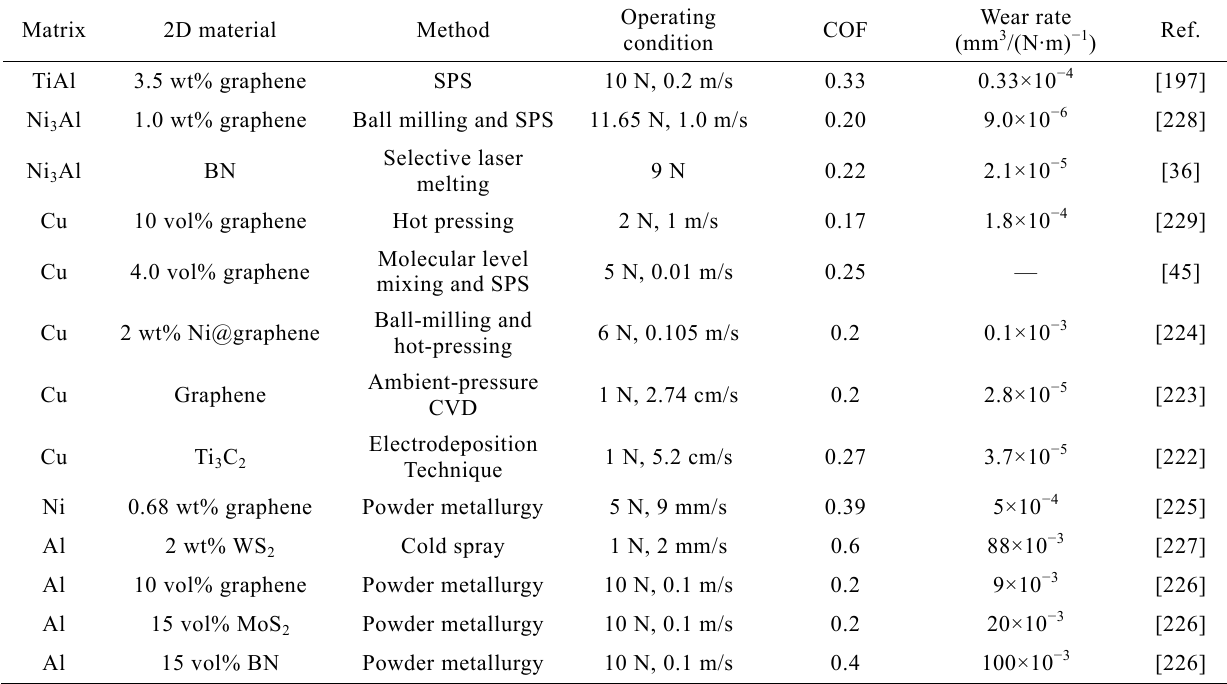
Table 6 Tribological properties of metal composites reinforced with 2D materials. Matrix 2D